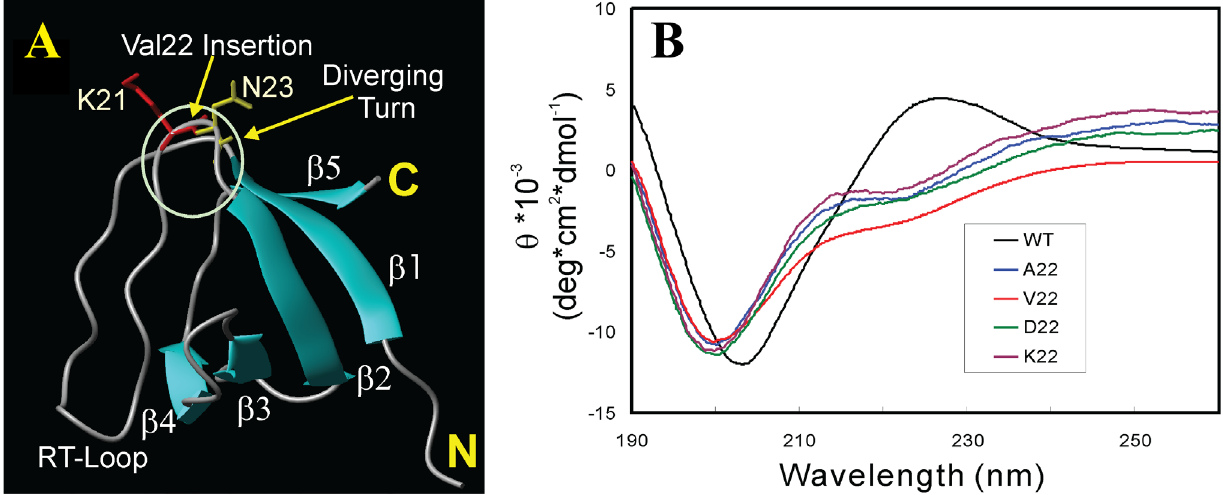
Figure 7. Conformations of wild-type Nck2 SH3 domain and its mutants. ( A ) NMR structure of the first SH3 domain of the human Nck2 protein (2B86) with the secondary structures and position of the inserted Val residue indicated. ( B ) Far-UV CD spectra of the wild-type SH3 and its four insertion mutants which were collected at protein concentrations of 20 µM at 25 ° C. The wild-type SH3 was dissolved in 5 mM phosphate buffer (pH 6.2) while the insertion mutants were solubilized in unsalted water (pH